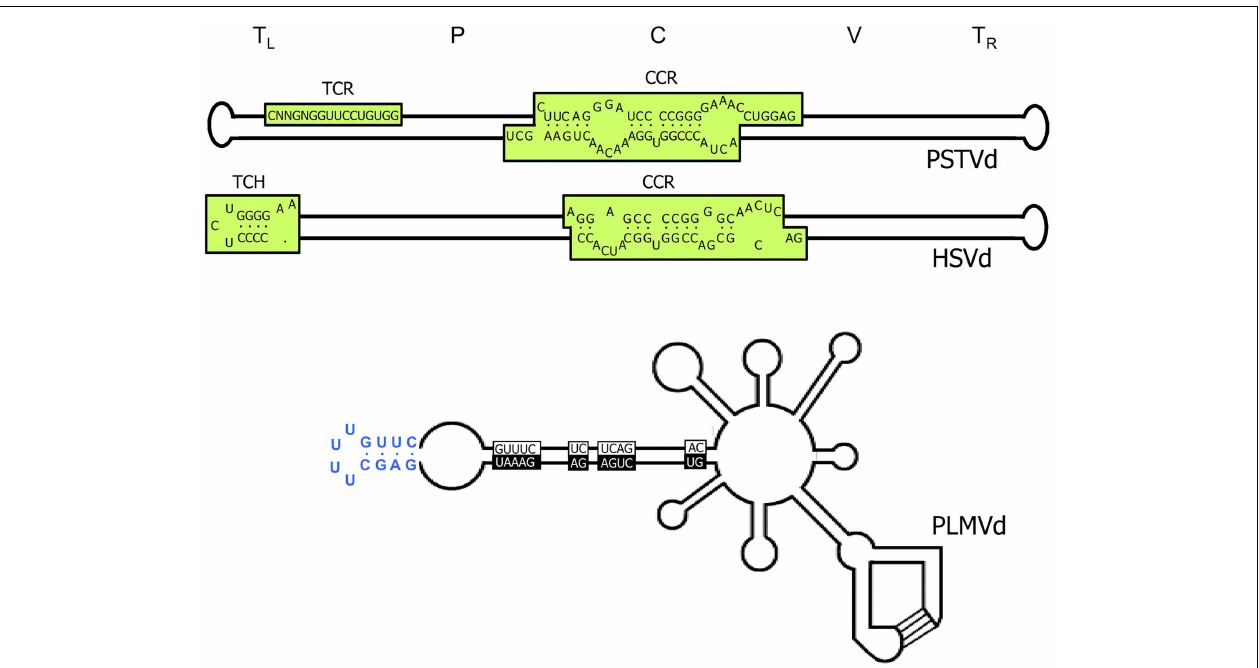
secondary structure of the genomic RNA of Peach latent mosaic viroid (PLMVd; family Avsunviroidae ), in which the sequences conserved in most natural hammerhead ribozymes are boxed with black and white backgrounds for the ( + ) and ( − ) polarities, respectively; the kissing-loop interaction is indicated with lines, and the characteristic 12-nt hairpin insertion of the reference variant containing the pathogenicity determinant of an extreme chlorosis (peach calico) is highlighted with blue color. For a more detailed representation of the PSTVd secondary structure see Figure 5